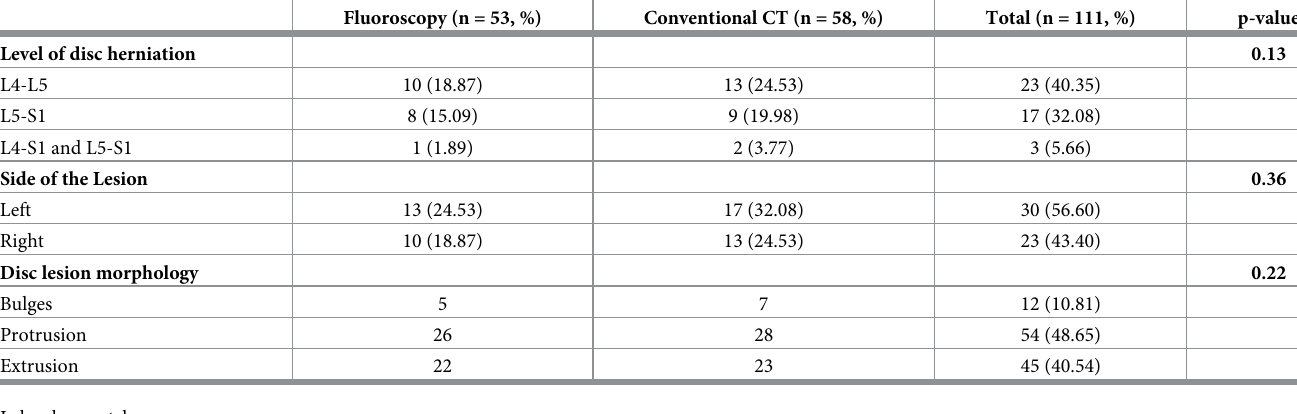
Table 2. Disc herniation characteristics sorted by guidance technique (Fluoroscopy, conventional